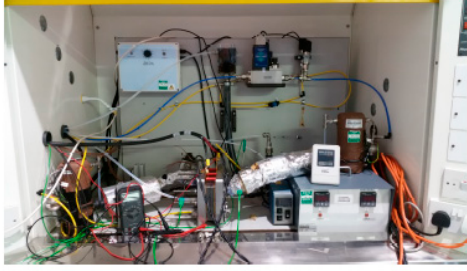
Figure 1. Polymer electrolyte membrane (PEM) fuel cell test bench.